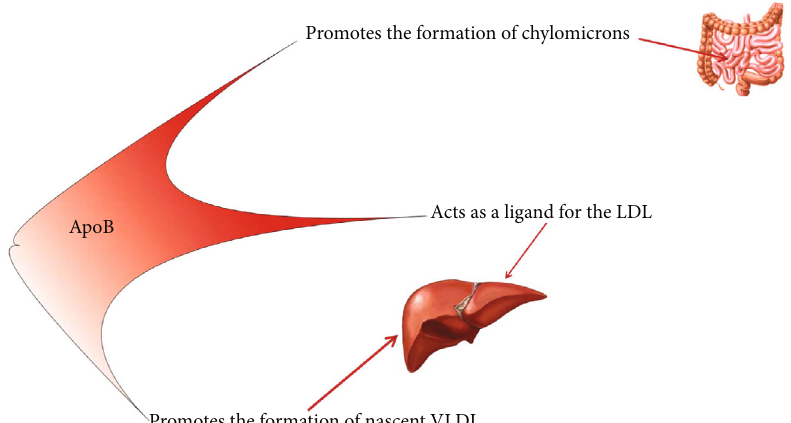
Figure 4: The roles of ApoB. In the liver, ApoB promotes the formation of nascent VLDL and also is essential for the linking of LDL particles to LDLR for cellular absorption and degradation of LDL particles. In the intestine, ApoB stimulates the formation of chylomicrons. LDL: low- density lipoprotein; VLDL: very low-density